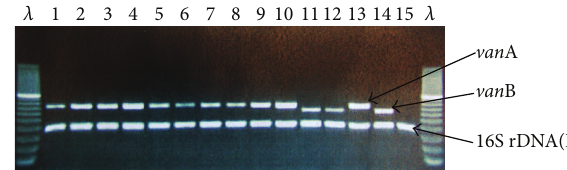
Figure 1: Agarose gel electrophoresis of PCR amplified products of vancomycin-resistant enterococci (VRE) isolates obtained from Trinidad and Tobago in 2008 to 2012. Lane 𝜆 is the markers. Lanes one–ten represent van A positive E. faecium and lanes 11 and 12 represent van B positive E. faecalis from Trinidad and Tobago. Lanes 13–15 represent control strains of van A ( E. faecium ATCC 700221), with van B ( E. faecalis ATCC 51299) and Enterococcus vancomycin- sensitive ( E. faecalis ATCC 29212), and 16S rDNA is the Internal Amplification Control (IC),